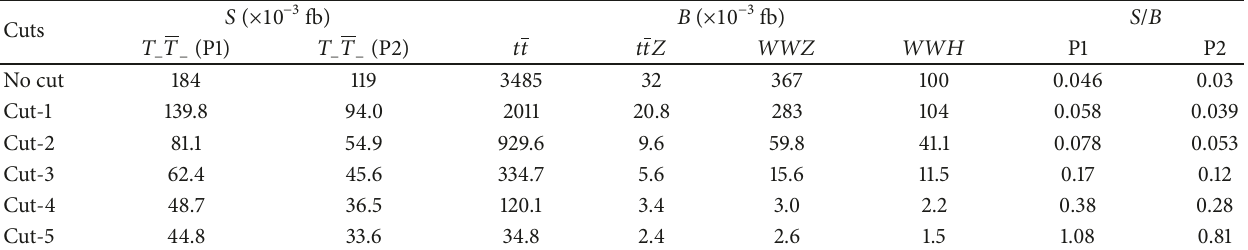
Table 1: Cut flow of the cross sections for the signal ( 𝑆 ) and the backgrounds ( 𝐵 ) for the two signal benchmark points (P1: 𝑓 = 700 GeV, 𝑅 = 1 ) and (P2: 𝑓 = 700 GeV, 𝑅 = 1.5 ) at √𝑠 = 1.5